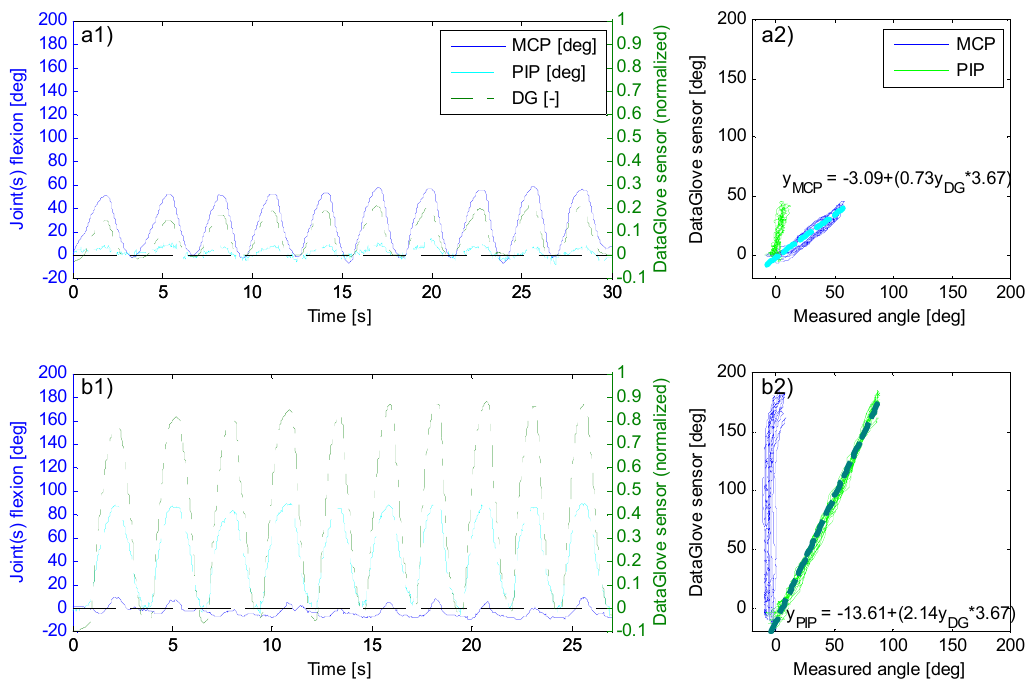
Figure C3. ( a1–b1 ) Raw metacarpophalangeal (MCP, a1 ) and proximal interphalangeal (PIP, b1 ) joint measurement data collected through Marker Tracking and normalized Data Glove (DG) sensor readings for the index finger; ( a2–b2 ) Joint flexions measured through Marker Tracking versus data glove sensor readings rescaled to range [0 210]. The gradient of the linear least-squares fit function provides the weights w DG and w DG